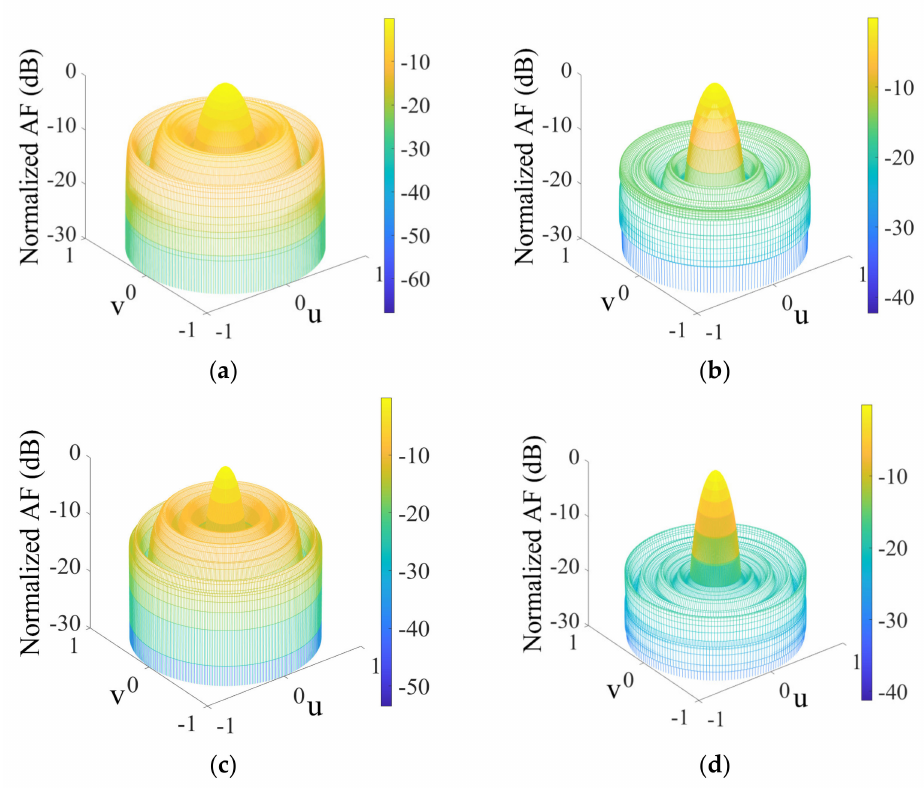
Figure 8. 3D radiation patterns of CAA. ( a ) 12 − element CAA uniform array; ( b ) 12 − element CAA